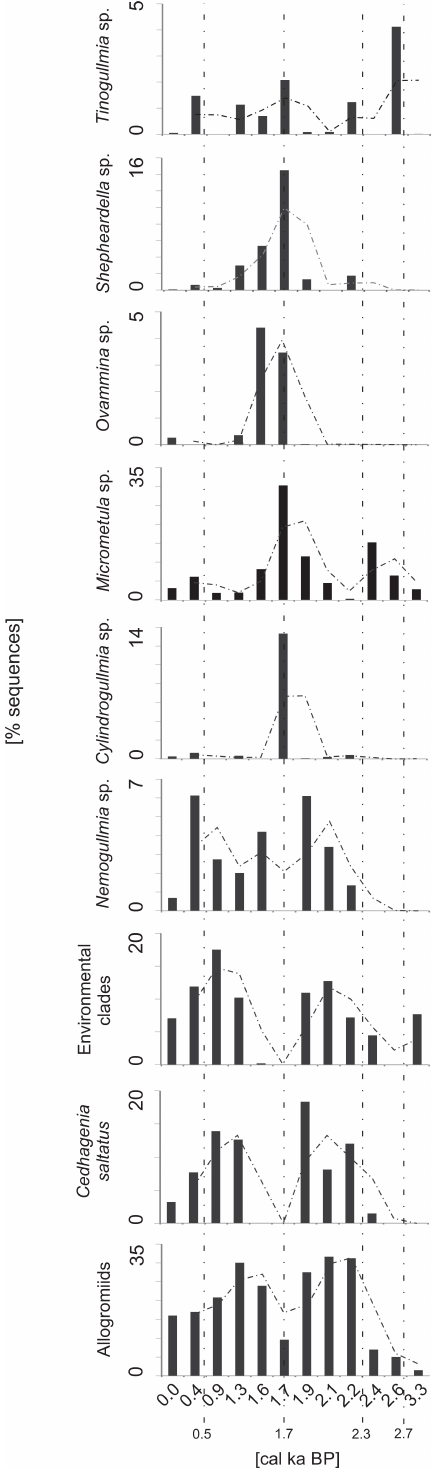
Figure 6. The dominant components of the monothalamous as- semblages. The abundance is expressed as the percentage of the monothalamous sequences, and the most abundantly sequenced taxa are presented. The trend (two-point average) is indicated with a dashed line.